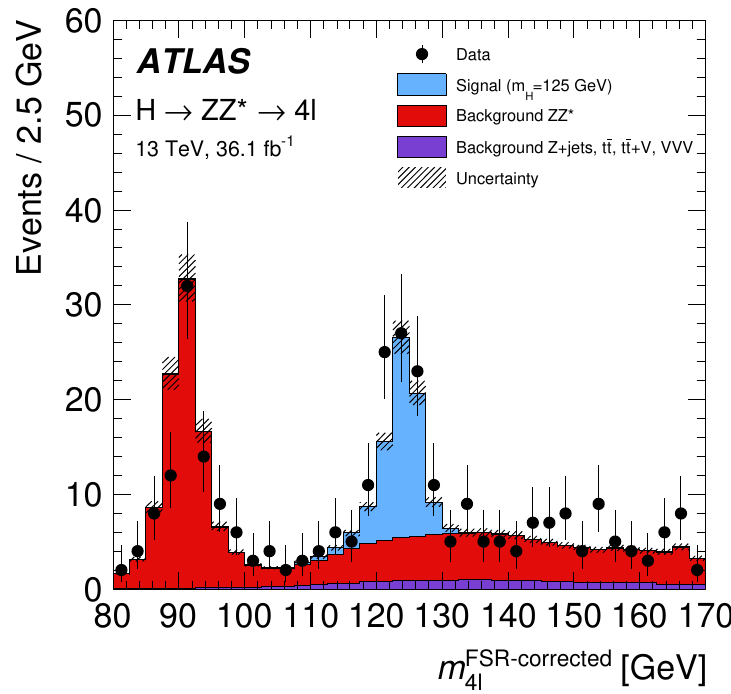
Figure 1. Four-lepton invariant mass distribution of the selected events before the m 4 ‘ requirement, corrected for (cid:12)nal-state radiation (FSR). The error bars on the data points indicate the statistical uncertainty. The SM Higgs boson signal prediction is obtained from the samples discussed